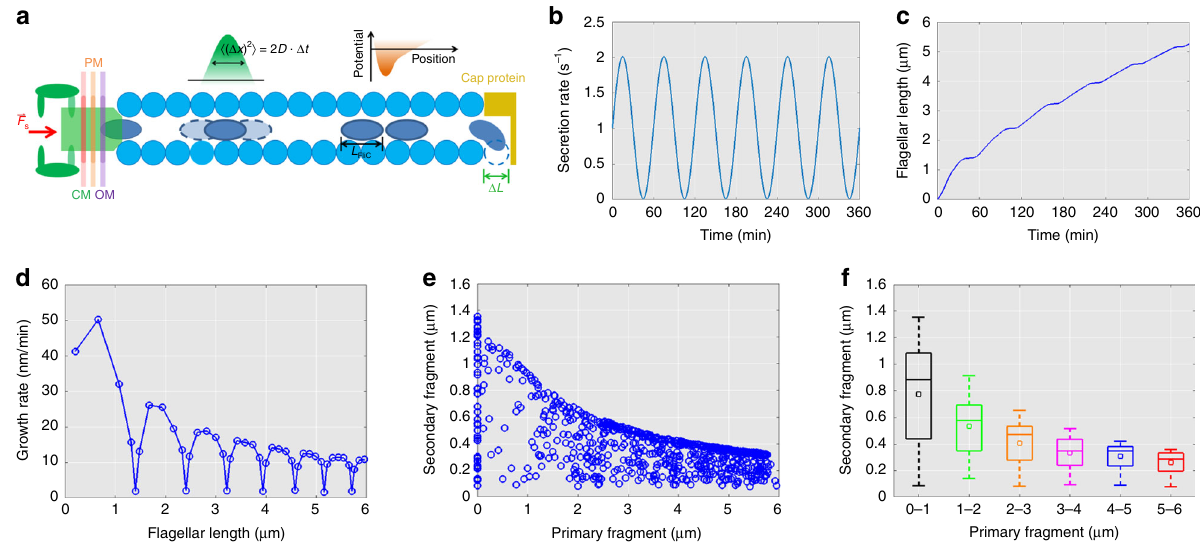
Fig. 6 Single- fi le injection-diffusion model explains punctuated fl agellar growth mechanism. a Schematic of single- fi le injection diffusion model. We fi rst assume that T3FSS exerts a force on unfolded fl agellin until it completely enters the central tube. Once the unfolded fl agellin is inside the tube, it moves via diffusion. The single- fi le diffusion is modeled as one dimensional diffusion in the channel and the each fl agellin subunit repels the other fl agellin subunits, where encountered, via a Lennard-Jones potential. Finally, when an unfolded fl agellin arrives at the distal end of the fl agellum, it polymerizes onto the growing end of the fi lament immediately. b A simple sinusoidal variation form of the fl agellar injection rate with a secretion variation period of T S = 60 min. c The simulated fl agellar length versus time and d fl agellar growth rate versus fl agellar length. e A population simulation with different variation period T S and variation phase φ is plotted. f Box plot of e has been binned at a 1- µ m